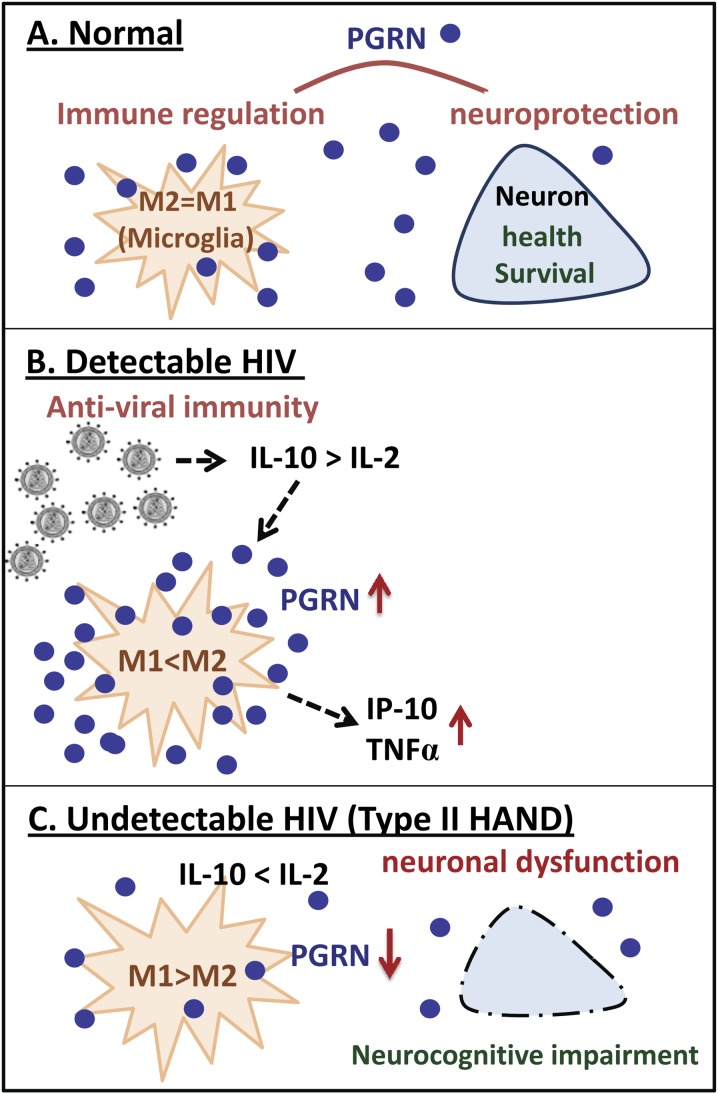
Hypothetical scenario linking HIV, inflammation, PGRN and neurocognition based on our data and literature.(A) under normal homeostatic conditions, PGRN is produced by neurons and microglia and contributes to neuroprotection and immune balance. (B) In HIV+ individuals with detectable HIV replication, viral infection contributes to M2 predominant macrophage/microglial cytokine environment (M2>M1) in part due to IL-10 production and CD4+ T cell loss. This environment favors PGRN overproduction. IP-10 and TNFα are also co-regulated with PGRN, possibly downstream of PGRN, though the mechanisms are unclear. PGRN contributes to innate antiviral immunity in HIV-infected macrophages. (C) In HIV+ individuals with undetectable virus, macrophages are under M1 predominant (M1>M2) conditions which decrease the production of PGRN. Reduction of PGRN in the CSF/CNS compartment in which the amount of PGRN is limiting, neuronal function and survival is further compromised contributing to neurocognitive impairment (“Type II HAND”) (See text for detail).